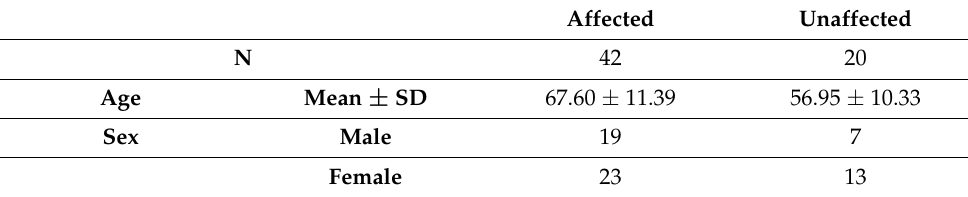
Table 1. Features of Genetics of GLaucoma Evaluation in the AMish (GGLEAM) Study Participants. Of the 42 glaucoma-affected Amish in this study, 37 individuals have POAG and 5 have another form of glaucoma including 1 person with chronic angle closure glaucoma and 4 individuals with pigmentary glaucoma. Age values represent the study participants’ ages at their eye exams. The age range for study participants with glaucoma was 40–85, and the age range for unaffected individuals was 42–81.